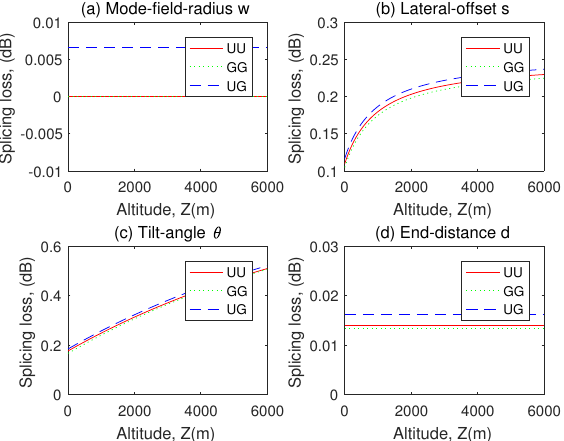
Figure 6. Splice loss versus altitudes, under the same ideal conditions, the four fusion variables affected by the high altitude environment have an impact on the splice loss of two kinds of optical fibers, and the abscissa represents the altitude and the ordinate represents the splice loss. The length of G652D fiber and ULL fiber are both 500 m, and their characteristic parameters are described in Table 1. “UU” means “ULL-ULL”; “GG” means “G652D-G652D”; and “UG” means “ULL-G652D”. Under these three different fusion modes, ( a ):MFD mismatch; ( b ):lateral offset; ( c ):angle tilt; ( d ):end face gap, as shown in Figure